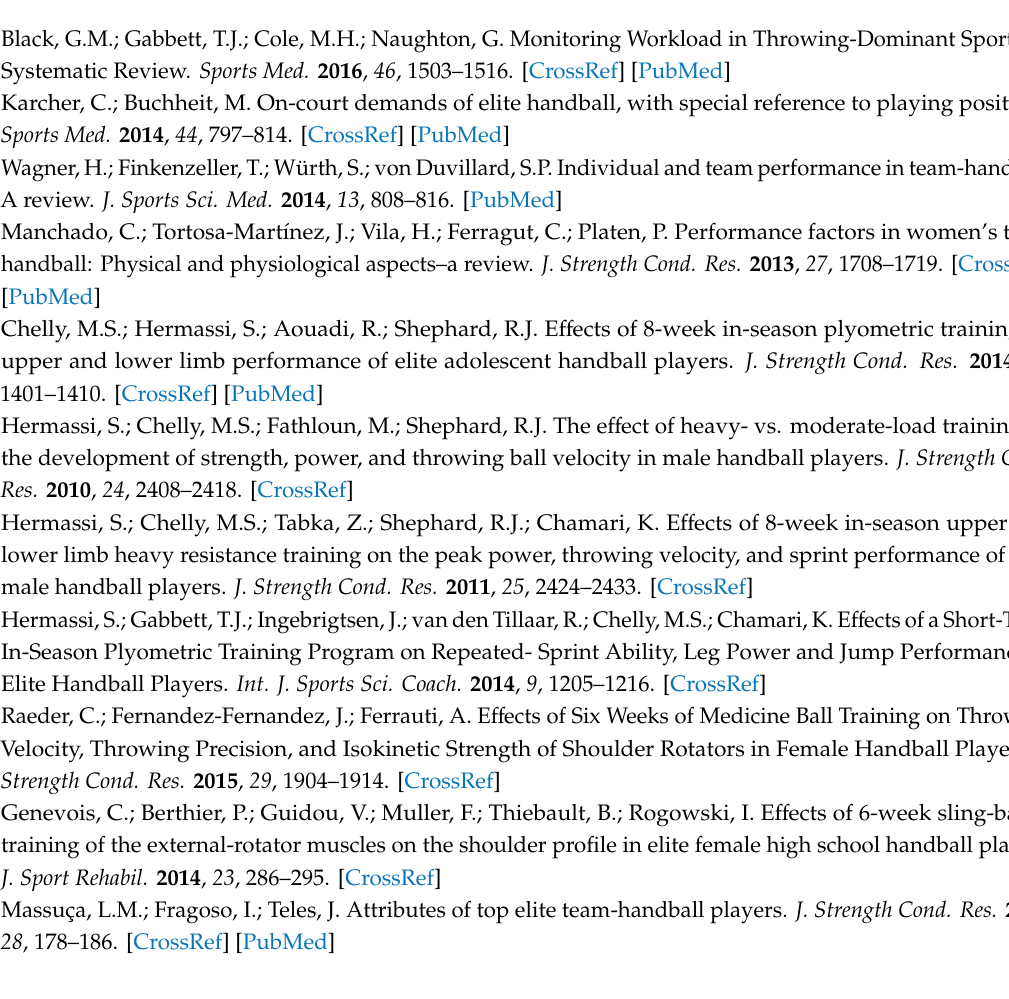
Table S1: Quality assessment of studies included in the present systematic review and